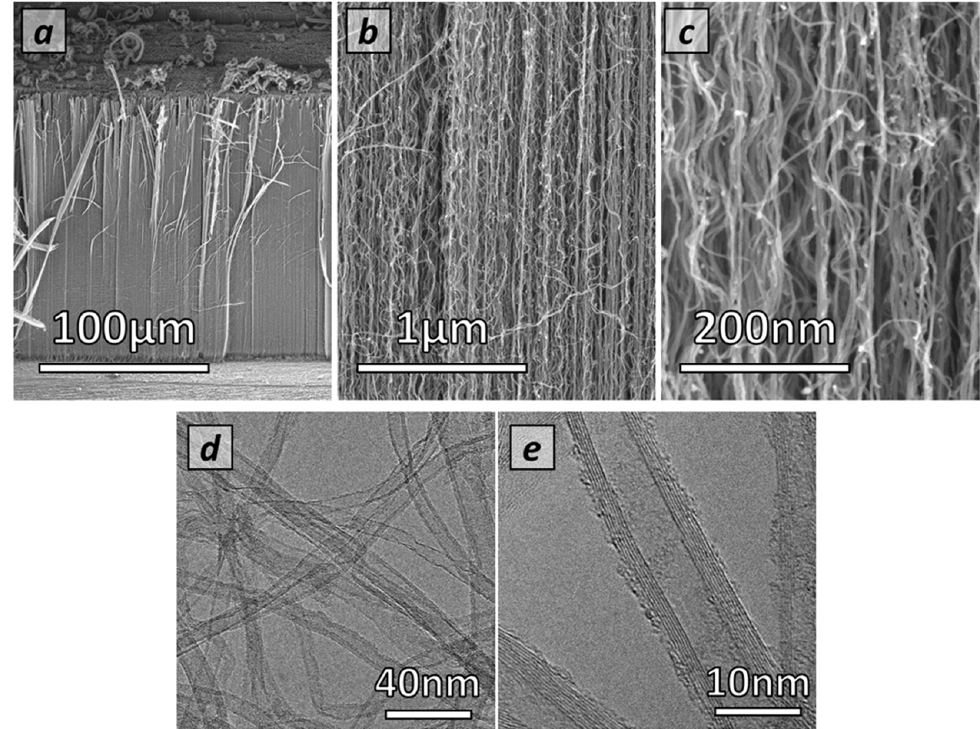
Figure 3. ( a – c ) typical SEM micrographs of clean VACNT carpet at different magnifications; ( d , e ) TEM and HRTEM micrographs of individual